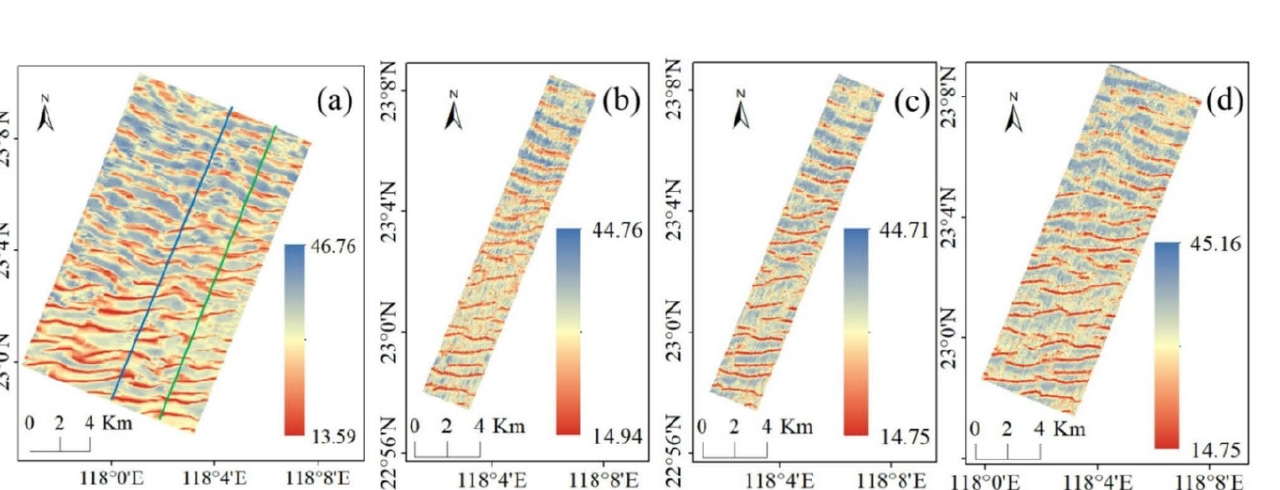
Figure 9. ( a ) Water depth in region A1 obtained by interpolating with 500 m interval bathymetric lines. The blue line and green line indicate the 50% and 75% demarcation lines of the A1 region, respectively, ( b ) predicted water depth obtained from Model I, ( c ) predicted water depth obtained from Model II, and ( d ) predicted water depth obtained from Model III.